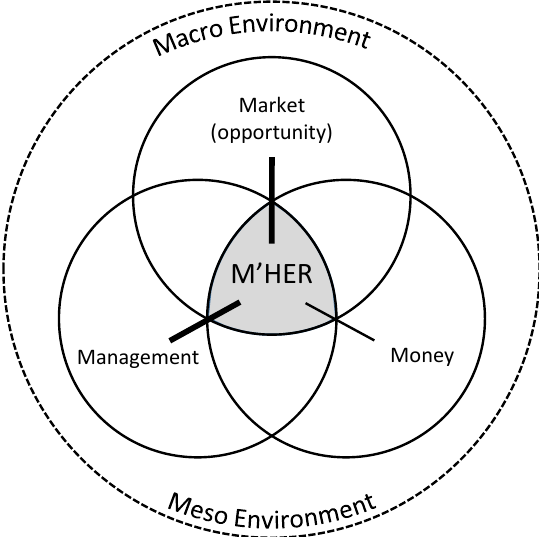
Figure 2. 5Ms Model for Women